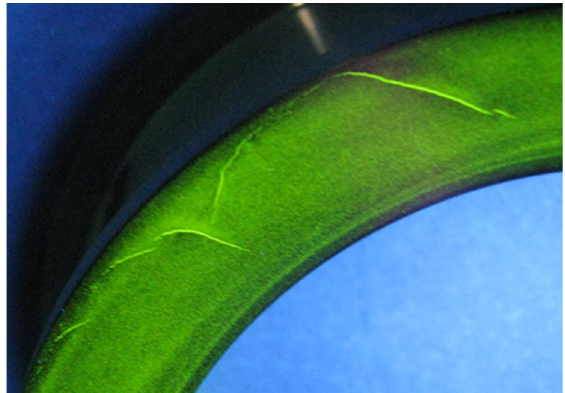
Figure 3. Crack on the outer hull of four-point bearing.